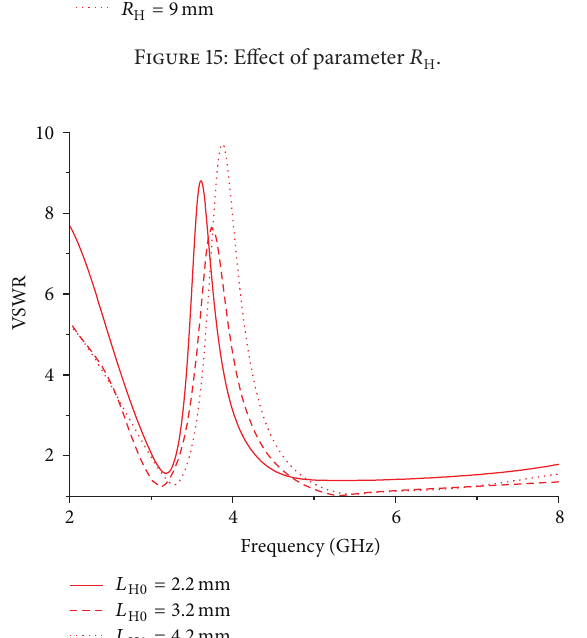
Figure 17: Effect of parameter 𝐿